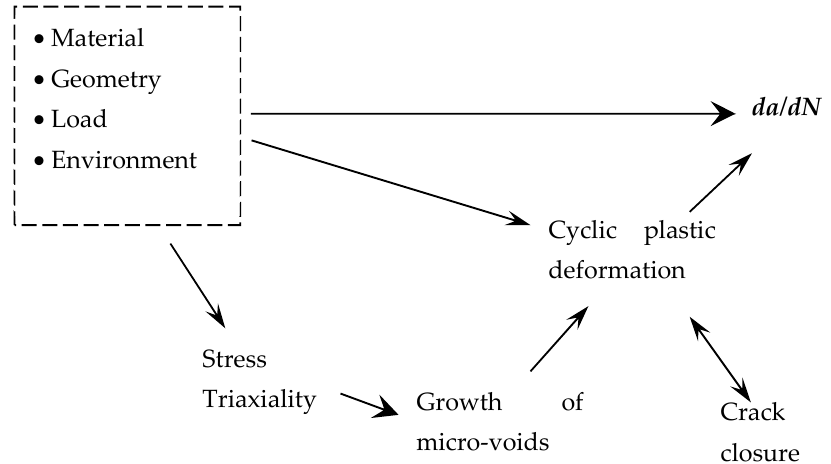
Figure 1. Schematic illustration of mechanisms and parameters involved in FCG modelling.